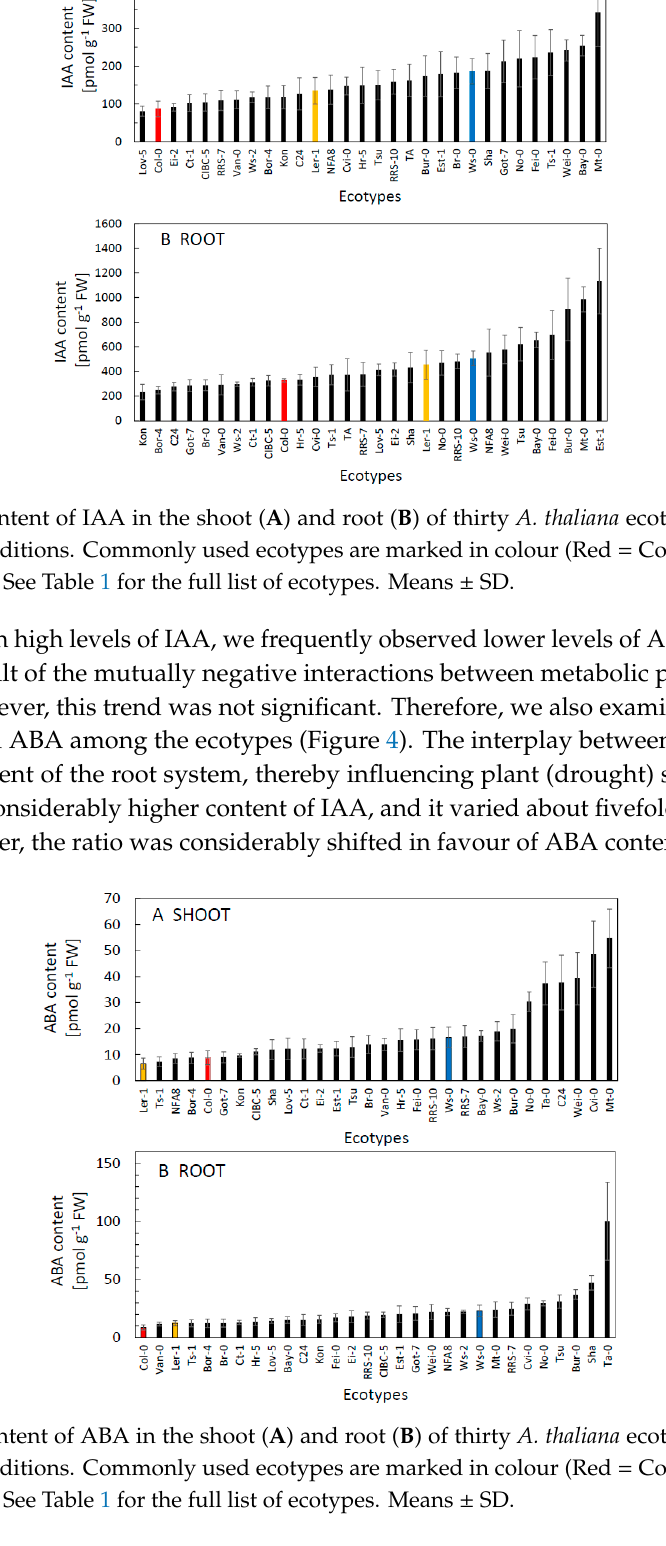
Figure 3. The content of ABA in the shoot ( A ) and root ( B ) of thirty A. thaliana ecotypes grown 21d in controlled conditions. Commonly used ecotypes are marked in colour (Red = Col-0, Blue = Ws-0, Orange = Ler-1). See Table 1 for the full list of ecotypes. Means ± SD.